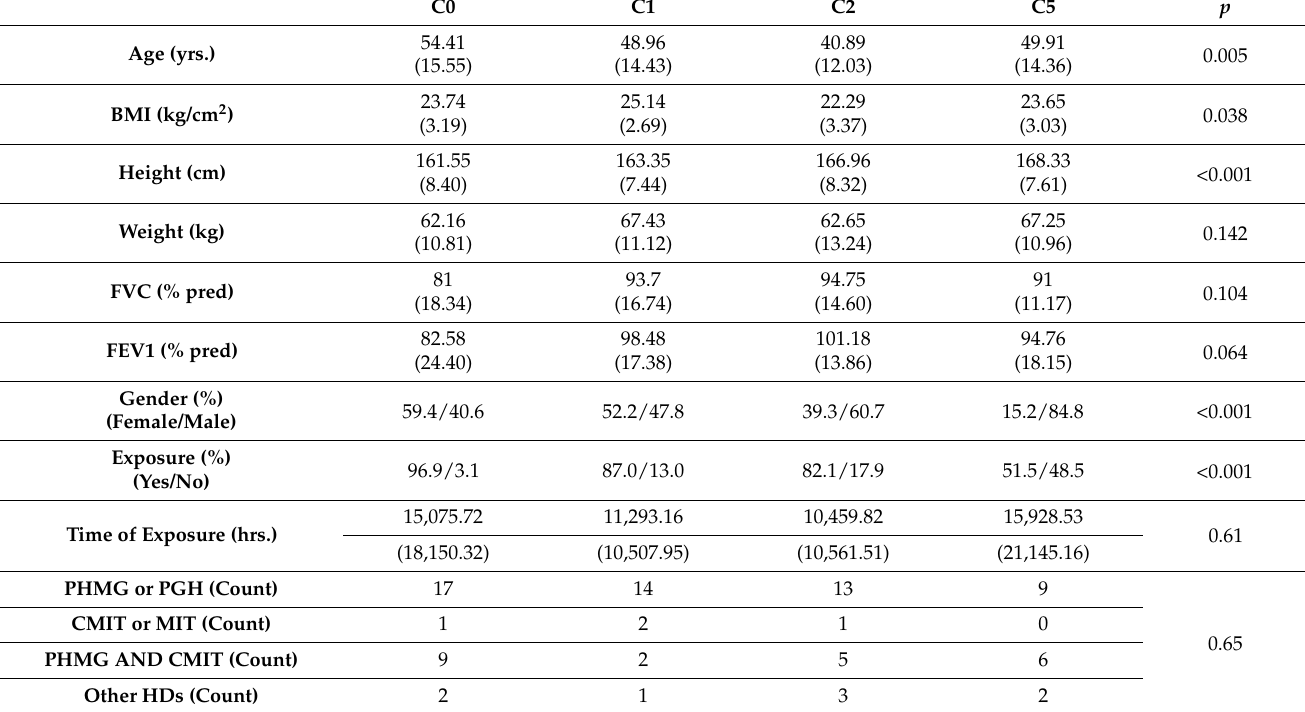
Table 2. Demographic data and PFT measurements for each cluster. Entries are mean (SD) unless otherwise specified. The differences between the means of independent groups were analyzed by Welch’s ANOVA with the Games–Howell method for post hoc pairwise tests. The chi-square test was used to examine the relationship between two categorical variables.